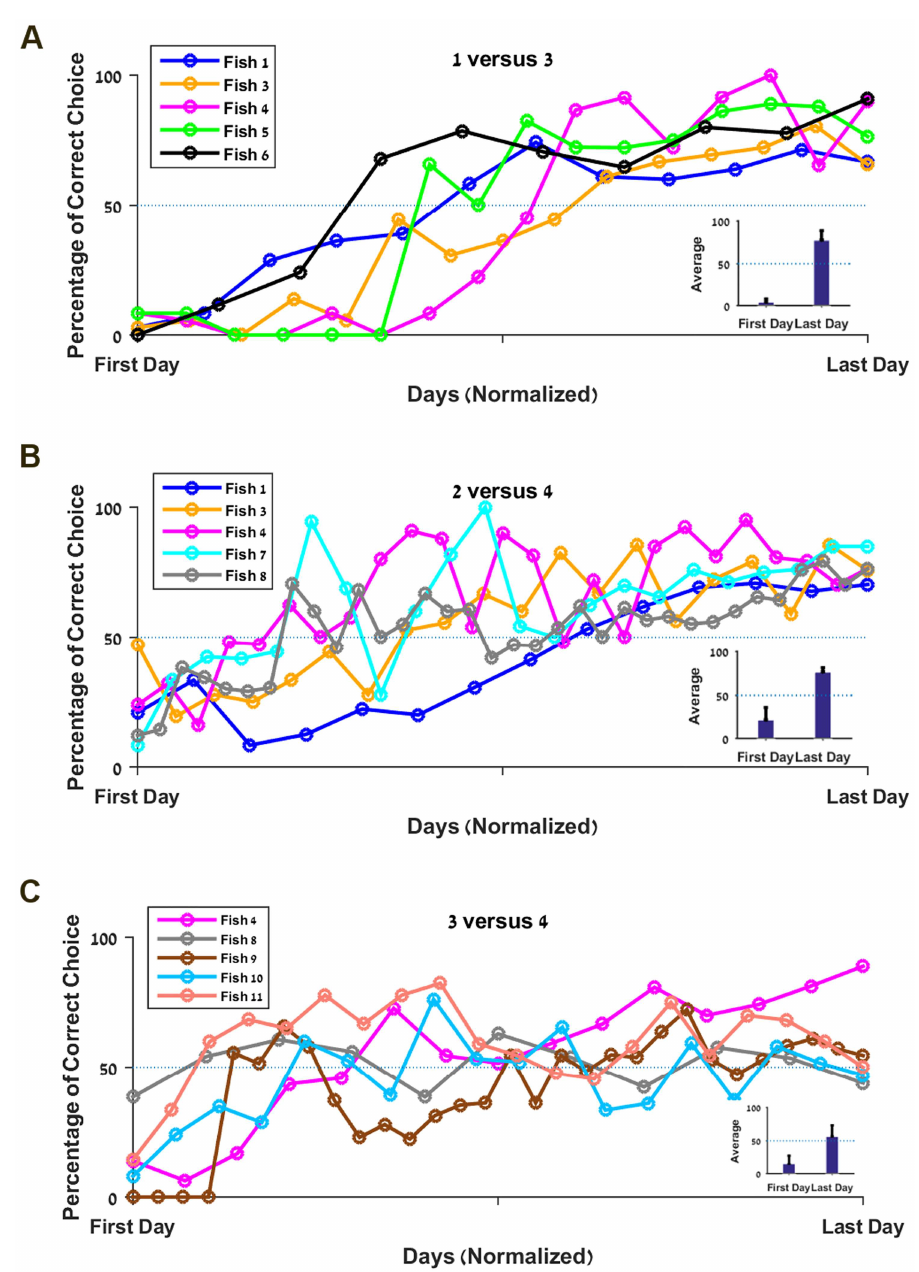
Fig 4. Fish can learn to associate value and shape. A. Success rate for each fish on the 1 versus 3 experiment over normalized time; inset: averagesuccess rate on the first and last day. B. Success rate for each fish on the 2 versus 4 experiment over normalizedtime; inset: averagesuccess rate on the first and last day. C. Success rate for each fish on the 3 versus 4 experiment over normalized time; inset: averagesuccess rate on the first and last day. The dashedline represents the chance level (50%)